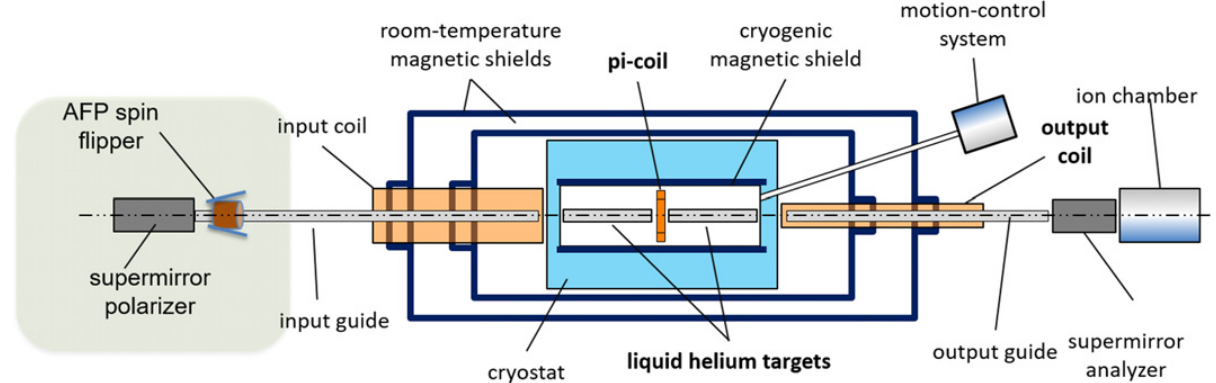
Figure 1. Top view diagram of the spin rotation apparatus [39]. The target consists of four chambers and a π -coil.